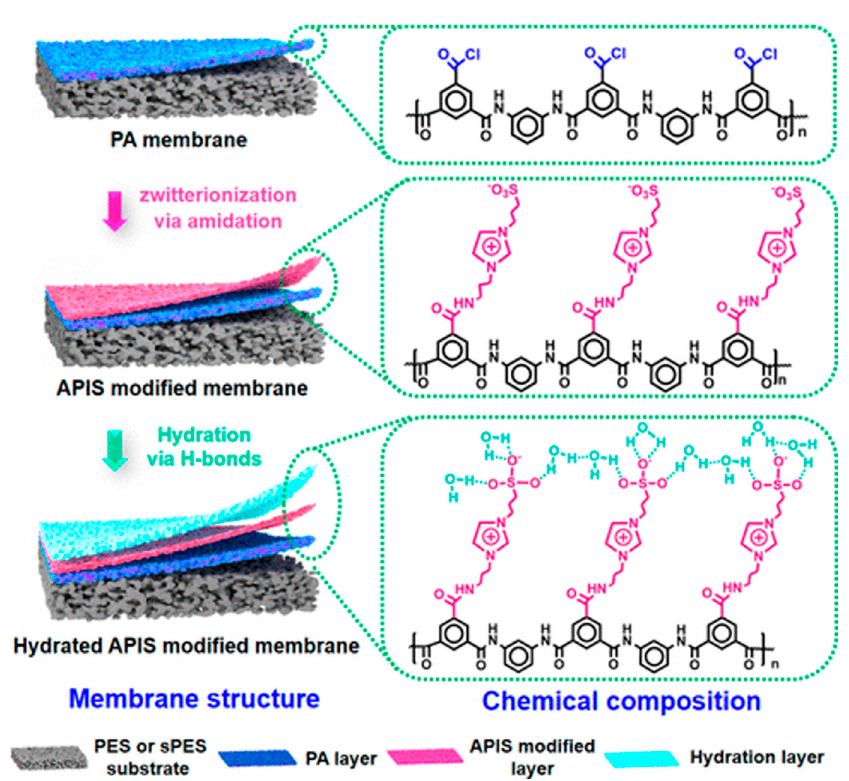
Figure 4. Schematics of 2nd interfacial polymerization for inclusion of zwitterionic moieties on FO membrane (reproduced from Chen et al. [76]).